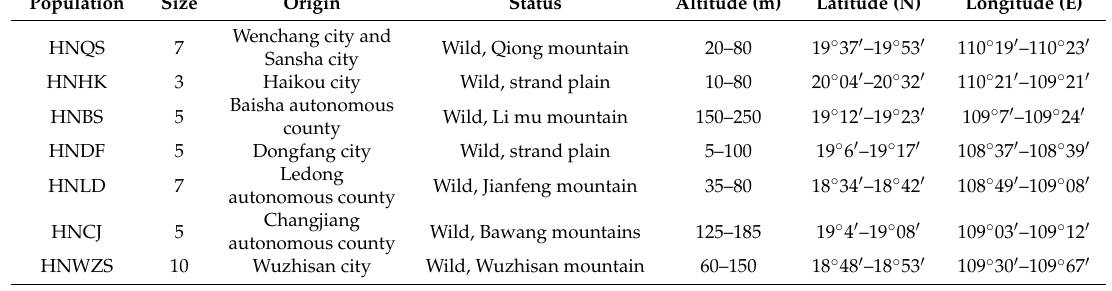
Table 1. Geographical location of seven investigated D. odorifera populations in Hainan Island of China.